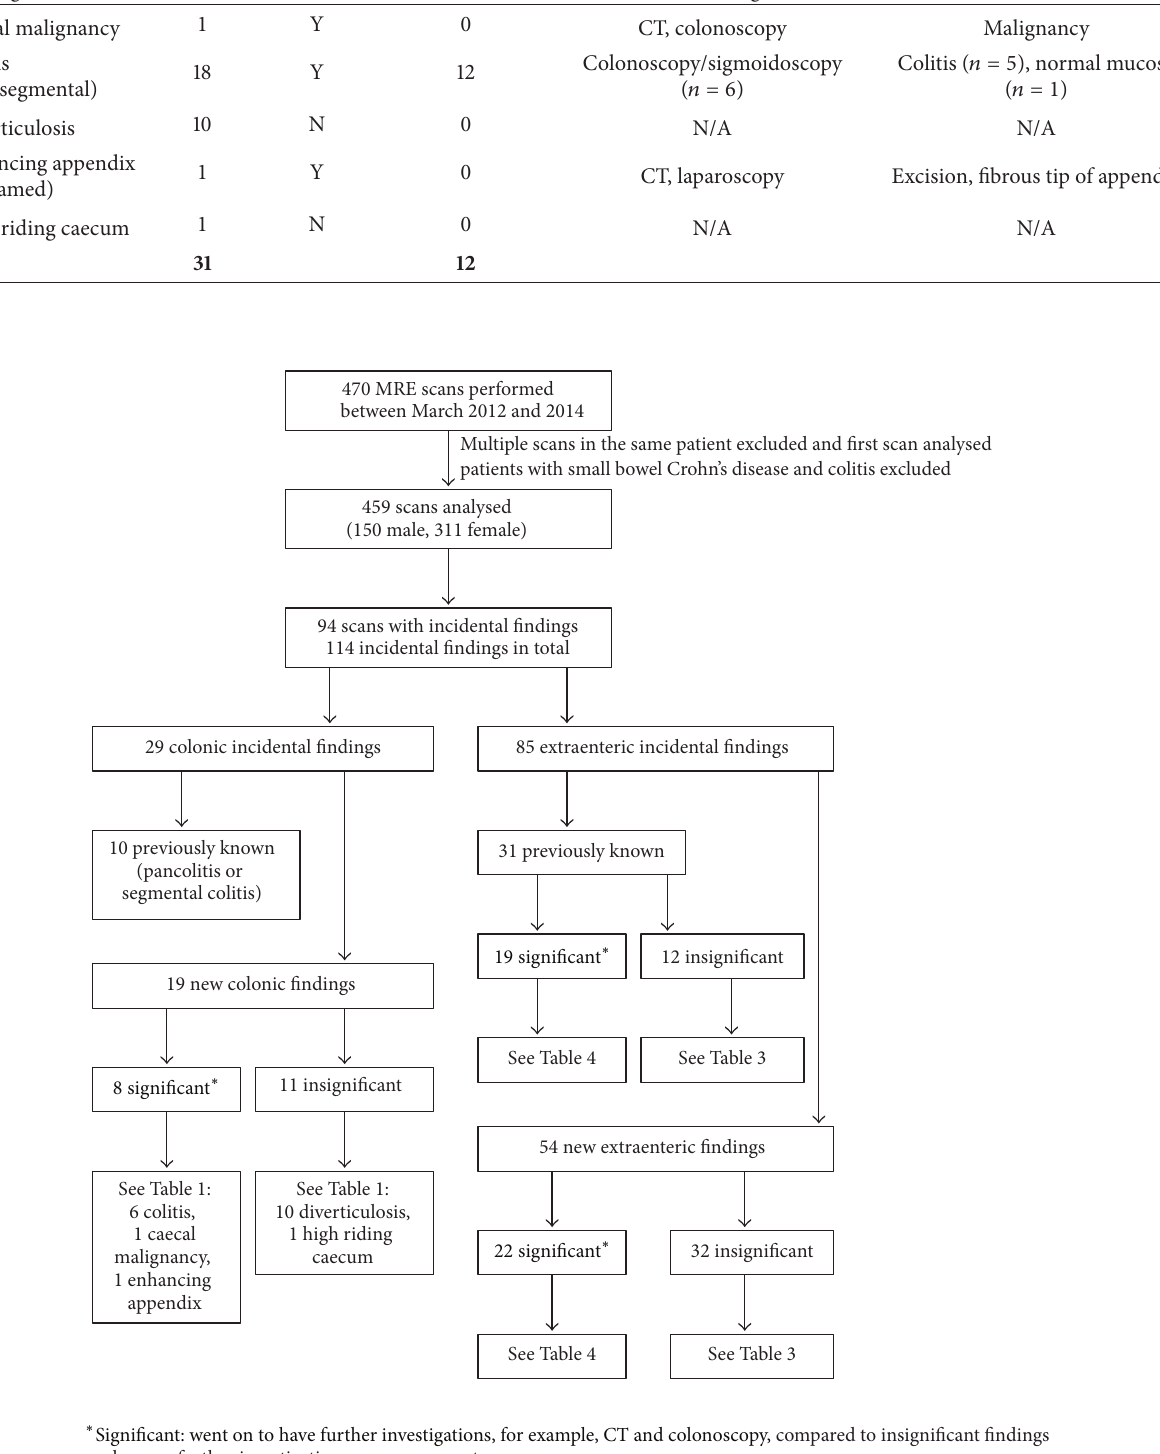
Figure 1: Flow diagram of patients identified for the